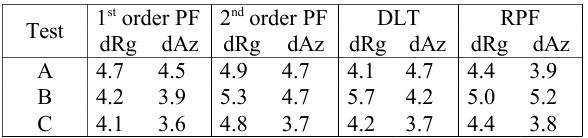
Table 1. CPs RMSE (pixels), in Range and Azimuth.